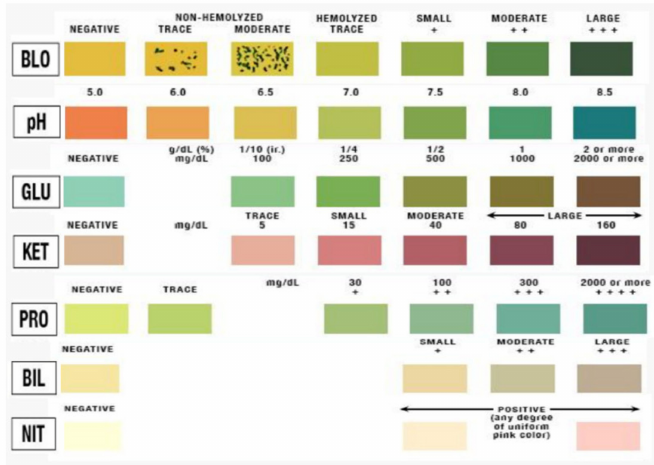
Figure 1. Urine dipstick color comparison test table.